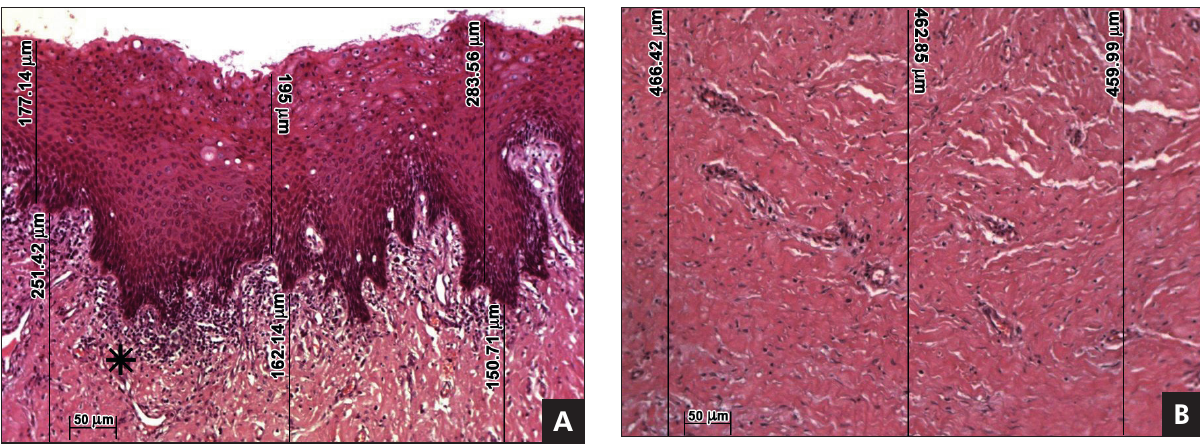
Figure 2 - Keratocystic ontogenic tumor specimen after enucleation. A: The epithelial lining is represented by nonkeratinized, hyperplastic stratified squamous epithelium. The three measurements (upper, middle, and lower) of the epithelial lining and fi- brous capsule are represented by black lines (hematoxylin-eosin stain, 100 × original magnification). B: Sequential measurements of the fibrous capsule shown in Figure 2A. The fibrous capsule consists of dense, sparsely cellularized, and slightly vascularized connective tissue with chronic inflammation (asterisk). The three measurements (upper, middle, and lower) are represented by black lines (hematoxylin-eosin stain, 100 × original